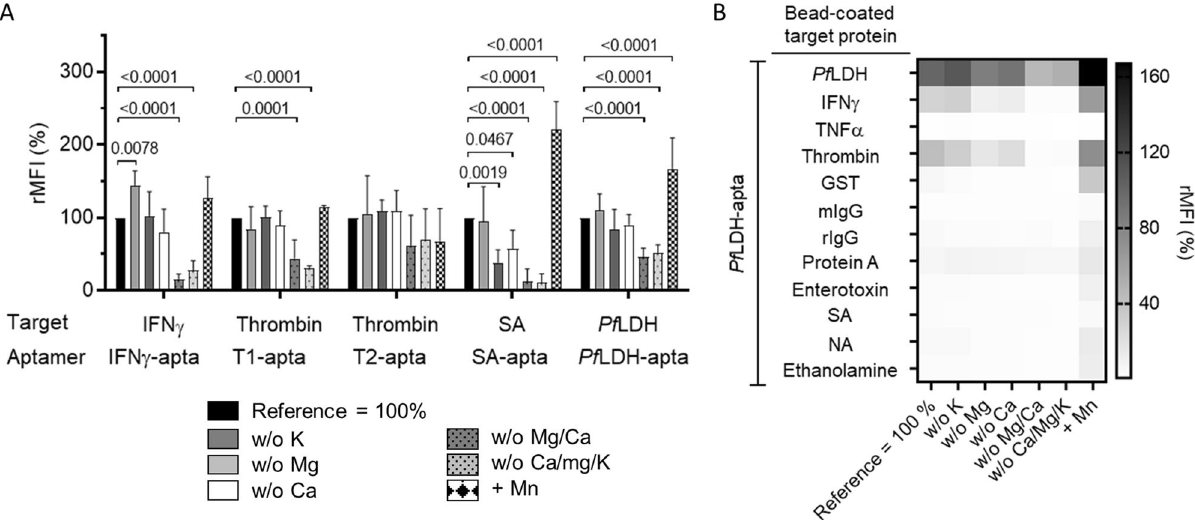
Figure 5. Influence of K + , Ca 2+ , Mg 2+ and Mn 2+ on aptamer binding. Fluorescence-labelled microbeads coupled with either IFNγ, streptavidin, thrombin or Pf LDH were incubated with indicated aptamers. ( A ) Streptavidin specific selection buffer functioned as a universal binding buffer with (+) or without (w/o) indicated components. ( B ) The Corresponding data of Pf LDH-apta to non-target proteins are shown in a heat map. For the other aptamers see supplementary information (Supplementary Fig. S5). All data represented as mean ± SD (n =